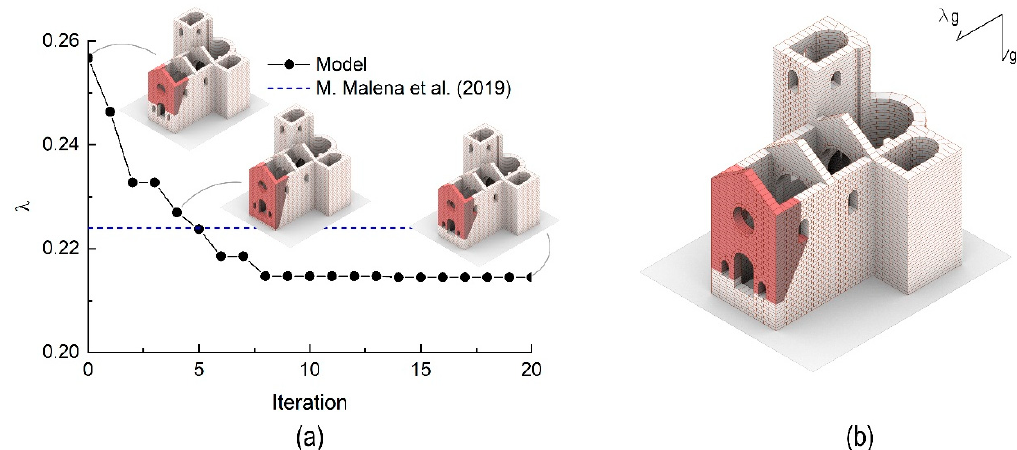
Figure 10. ( a ) Load multiplier vs. Iterations and comparison with the reference value arising by using a non-associative friction solution [41]. ( b ) Geometry representation of the failure mechanism at the last iteration.